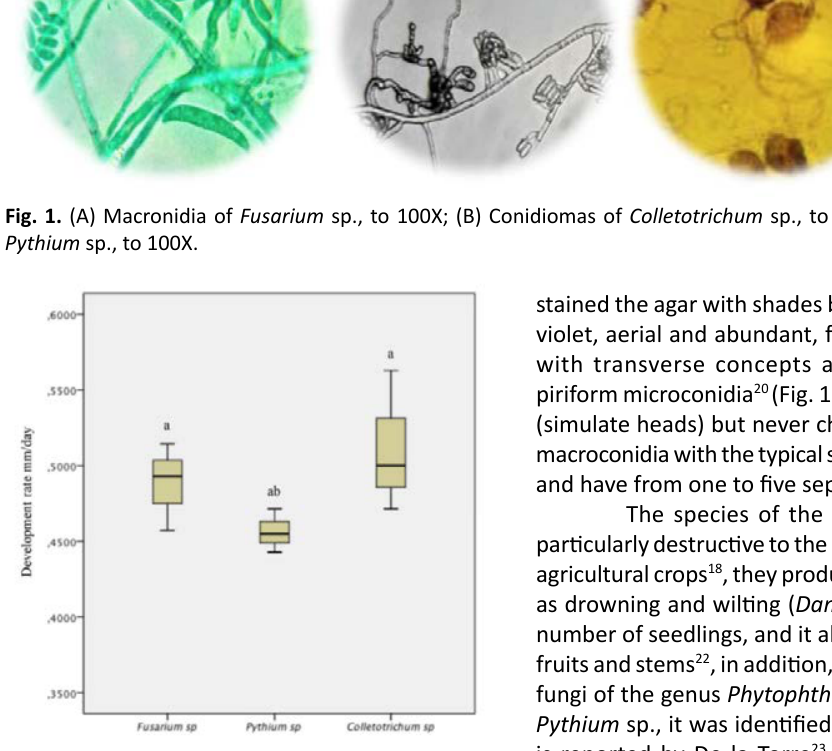
Fig. 2. Growth of fungi found in the Nopal vegetable crop. * Different letters mean significant difference between treatments according to Tukey